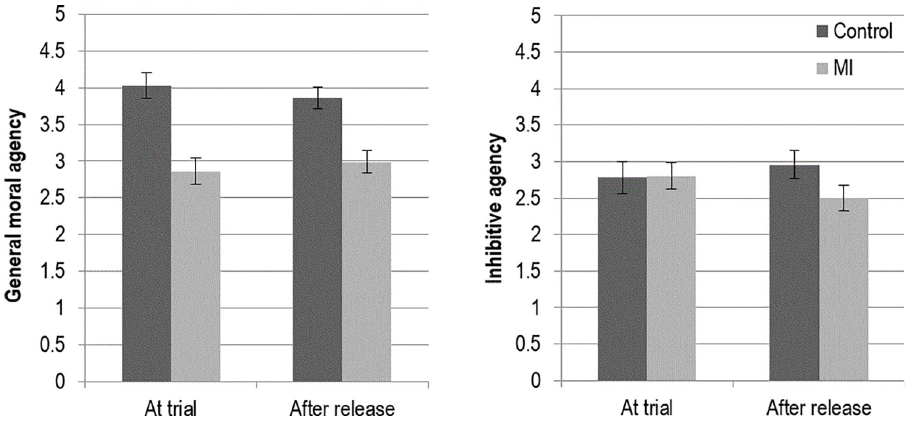
Fig 2. Perceived agency of defendant across experimental conditions (+/- 2